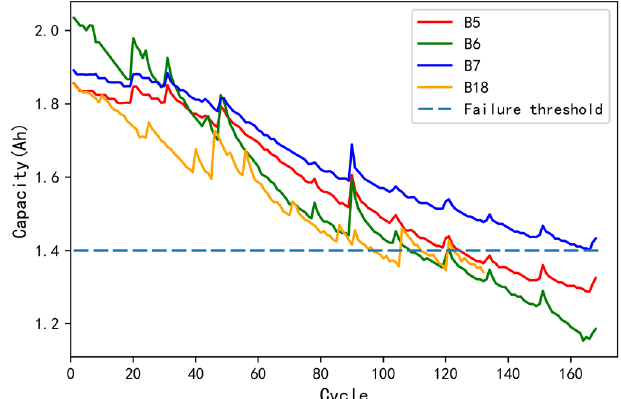
Figure 3. Battery capacity degradation curve.